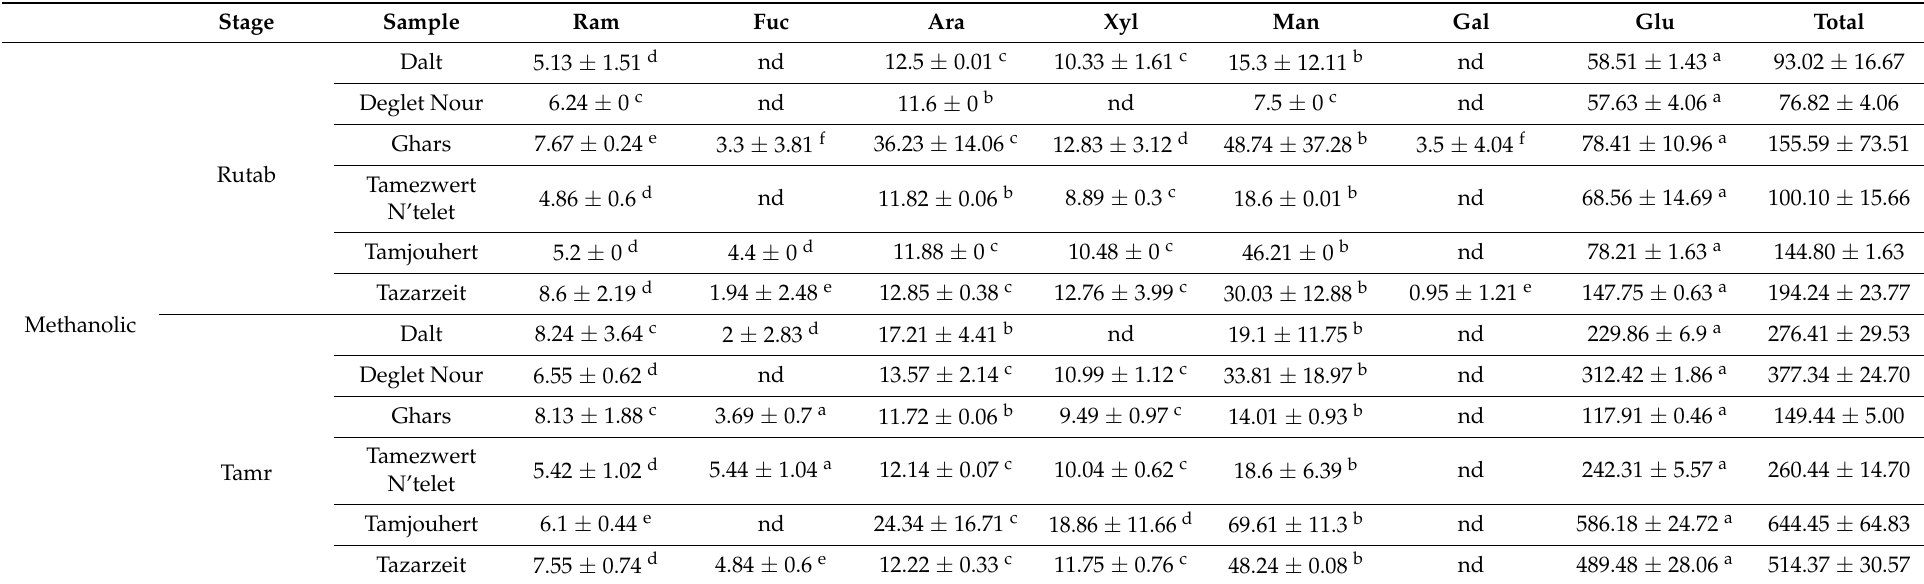
Values are mean ± SD. For each line, different letters indicate that the results are statistically different ( p < 0.05, b < a ). nd = not determined. Ram: Rhamnose; Fuc: Fucose; Ara: Arabinose; Xyl: Xylose; Mal: Maltose; Gal: Galactose; Glu: